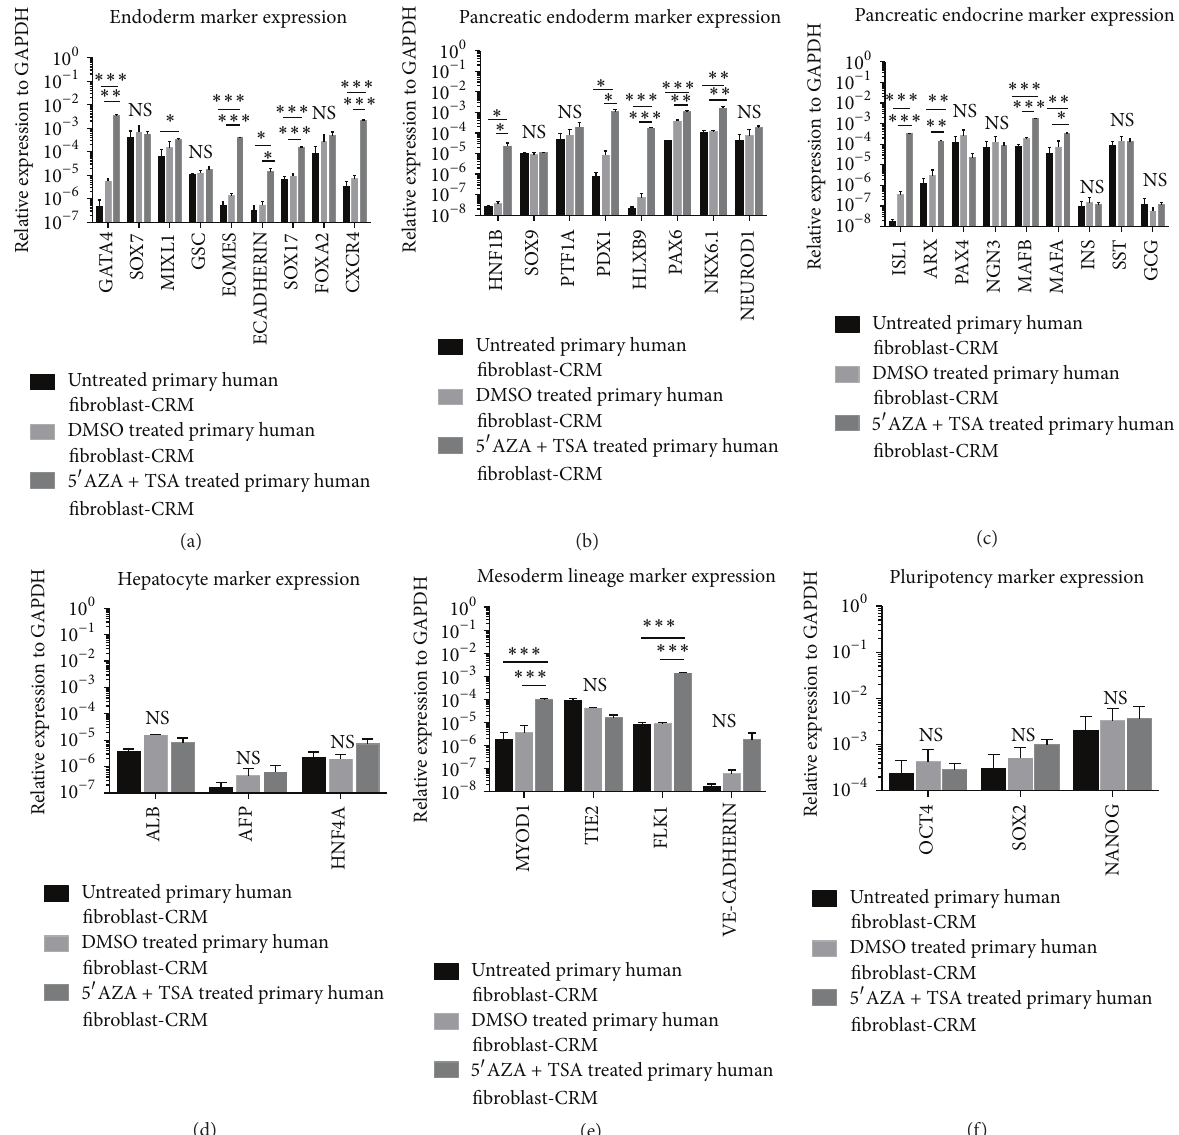
Figure 2: 5-Azacytidine (5AZA) and Trichostatin A (TSA) treatment of primary adult fibroblast induces transient definitive endoderm and pancreatic endoderm markers. (a) qRT-PCR analysis demonstrated induction of endodermal genes ( GATA4, MIXL1, EOMES, E-CADHERIN, SOX17, and CXCR4 but not SOX7, GSC, and FOXA2 ) in 5AZA + TSA-CRM treated primary human fibroblast cells. (b) qRT-PCR analysis demonstrated induction of pancreatic endoderm genes ( HNF1B, PDX1, HLXB9, PAX6, and NKX6.1 but not SOX9, PTF1A, and NEUROD1 ) in 5AZA + TSA-CRM treated primary human fibroblast cells. (c) qRT-PCR analysis demonstrated induction of the pancreatic endocrine genes ( ISL1, ARX, MAFB, and MAFA but not PAX4, NGN3, INS, SST, and GCG ) in 5AZA + TSA-CRM treated primary human fibroblast cells. (d) qRT-PCR analysis demonstrated no induction of hepatocyte genes ( ALB, AFP, and HNF4A ) in 5AZA + TSA-CRM treated primary human fibroblast cells. (e) qRT-PCR analysis demonstrated induction of mesoderm lineage genes ( MYOD1 and FLK1 but not TIE-2 and VE- CADHERIN ) in 5AZA + TSA-CRM treated primary human fibroblast cells. (f) qRT-PCR analysis demonstrated no induction of pluripotency genes ( OCT4, SOX2, and NANOG ) in 5AZA + TSA-CRM treated primary human fibroblast cells. Black bar, CRM treated primary human fibroblast cells; light grey bar, DMSO-CRM treated primary human fibroblast cells; dark grey bar, 3 𝜇 M 5AZA-CRM followed by 100 𝜇 M TSA-CRM treated primary human fibroblast cells. Gene expression is shown relative to the housekeeping gene GAPDH . Data represent the mean ± SEM (standard error of mean) of three independent experiments. Statistical significance tests were performed between 5AZA + TSA treated versus untreated fibroblast and 5AZA + TSA treated versus DMSO treated fibroblast. ∗ 𝑝 < 0.05 , ∗∗ 𝑝 < 0.01 , and ∗∗∗ 𝑝 < 0.001 by unpaired 2-tailed Student’s 𝑡 -test. NS, not